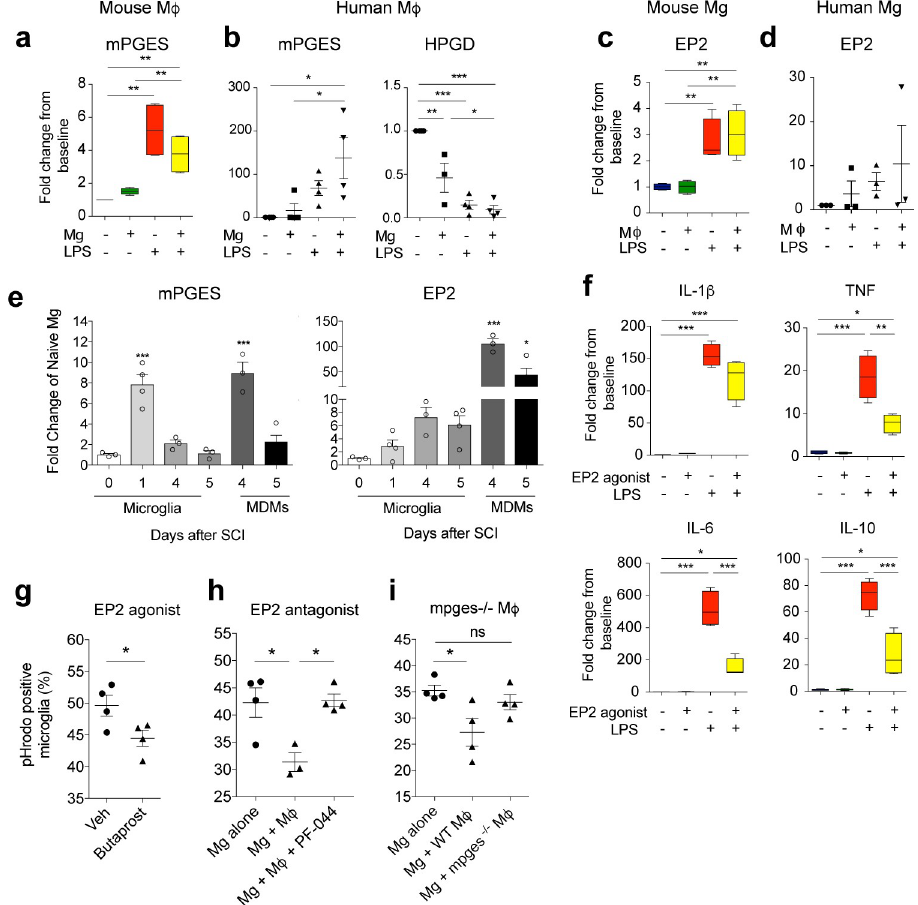
Fig 3. PGE 2 signaling via the EP2 receptor is responsible for macrophage-mediated suppression of microglia. ( a- d ) The bilaminar culture system was used to assess expression of inducible mPGES and EP2 receptor in adult mouse and human microglia and HPGD expression in human macrophages. ( e ) mPGES and EP2 receptor mRNA expression in FAC-sorted cells 1–5 days after SCI in mice. ( f ) Adult mouse microglial mRNA expression of four key inflammatory cytokines (IL-1 β , TNF, IL-6, and IL-10) treated with LPS (100 ng/mL) in the presence or absence of EP2 agonist, Butaprost (1 μ M). ( g ) Phagocytosis of pHrodo-labeled myelin by adult mouse microglia is reduced by pretreatment with Butaprost (1 μ M; one hour). ( h ) Phagocytosis of pHrodo-labeled myelin by adult mouse microglia, either alone or in the presence of macrophages (M ϕ ) treated with vehicle or EP2 receptor antagonist, PF-0441894 (10 μ M). ( i ) Phagocytosis of pHrodo-labeled myelin by adult mouse microglia alone or in the presence of WT macrophages or macrophages from mPGES −/− mice. Statistical analysis for ( a-d, f ), two-way ANOVA with Bonferroni corrections ( n = 3–4), and ( e, g-i ), one-way ANOVA with Bonferroni corrections ( n = 3–4). Mean ± SEM. � p < 0.05; �� p < 0.01; ��� p < 0.001. Corresponding raw data ( S1 Data ). FAC, fluorescently activated cell; HPGD, hydroxyprostaglandin dehydrogenase; IL, interleukin; LPS, lipopolysaccharide; mPGES, microsomal prostaglandin E synthase-1; PGE 2 , prostaglandin E 2 ; SCI, spinal cord injury; TNF, tumor necrosis factor; WT, wild-type. containing pHrodo-myelin ( Fig 4D and 4E ). Many of these Tmem119+ microglia contain or are closely associated with the fluorescently tagged myelin ( Fig 4D and 4F ). Importantly, the percentage of total microglial cells in the corpus callosum that are in contact with or contain pHrodo-myelin is significantly increased in EP2 antagonist–injected mice compared with con- trols ( Fig 4C, 4D and 4F ). These data indicate that blocking the EP2 receptor pathway in vivo promotes microglial phagocytic activity and increases recruitment of microglia to the site of injury. In summary, in vivo and in vitro studies suggest macrophage production of PGE at the EP2 receptor to mediate suppression of microglial phagocytosis.